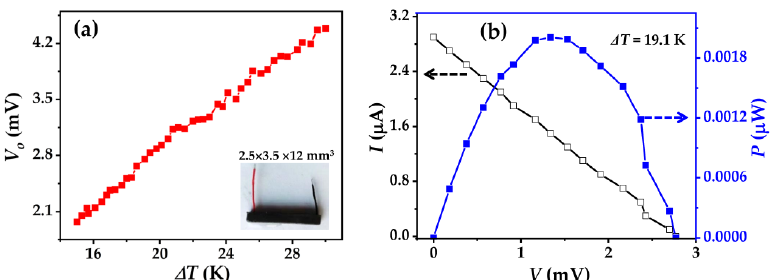
Figure 8. Power generation of Bi 0.5 Sb 1.5 Te 3 /CNTs cement composites at 0.6 vol.% Bi 0.5 Sb 1.5 Te 3 . ( a ) temperature difference ( Δ T) dependences of open ‐ circuit voltage (Vo) and ( b ) work voltage (V) dependences of work current (I) and power output (P) at a Δ T of 19.1 K. The P max value of Bi 0.5 Sb 1.5 Te 3 /CNTs co ‐ reinforced cement composites is not higher,